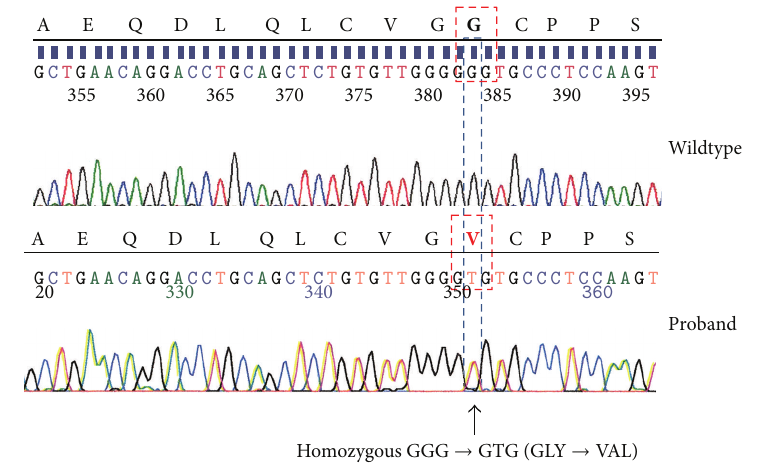
Figure 2: Sequencing demonstrating the hemojuvelin Gly320Val homozygous